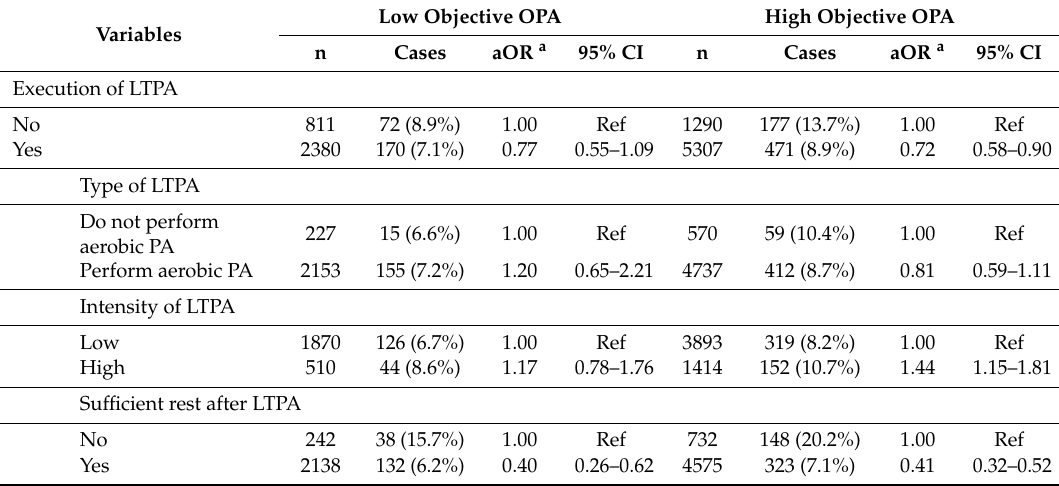
Table 5. Association between leisure time physical activity (LTPA) and insomnia according to objective occupational physical activity (objective OPA). [aOR = adjusted odds ratio; CI = confidence